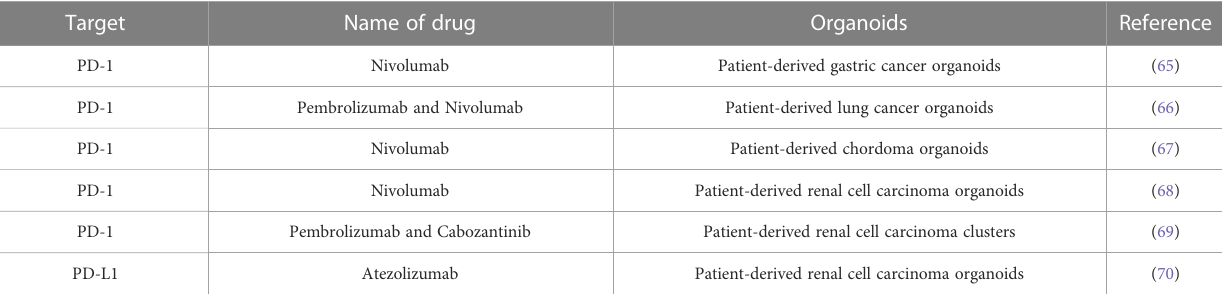
TABLE 2 Patient-derived organoids (PDOs) models in preclinical evaluation of immune checkpoint monoclonal antibody drugs.